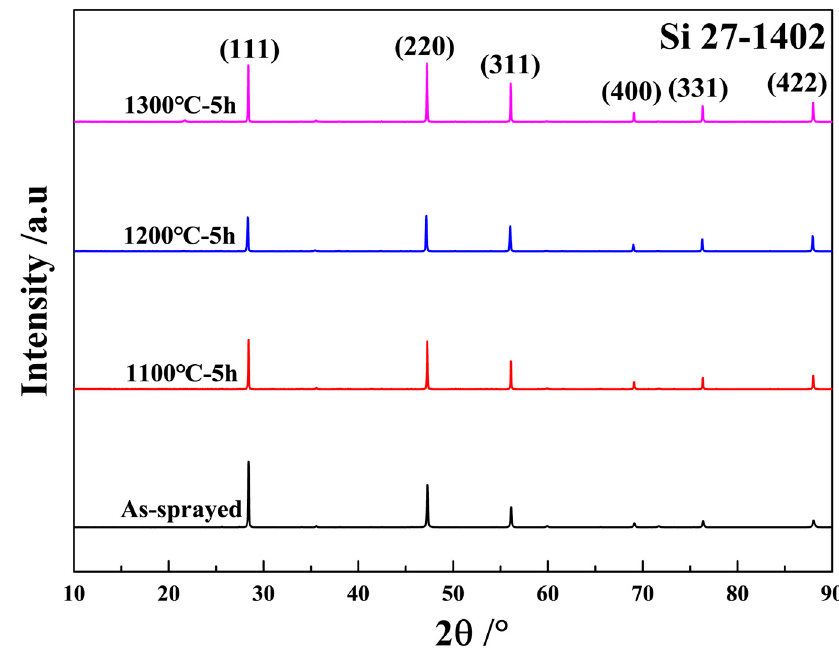
Figure 10. XRD measurements of the as-sprayed and annealed silicon coatings.